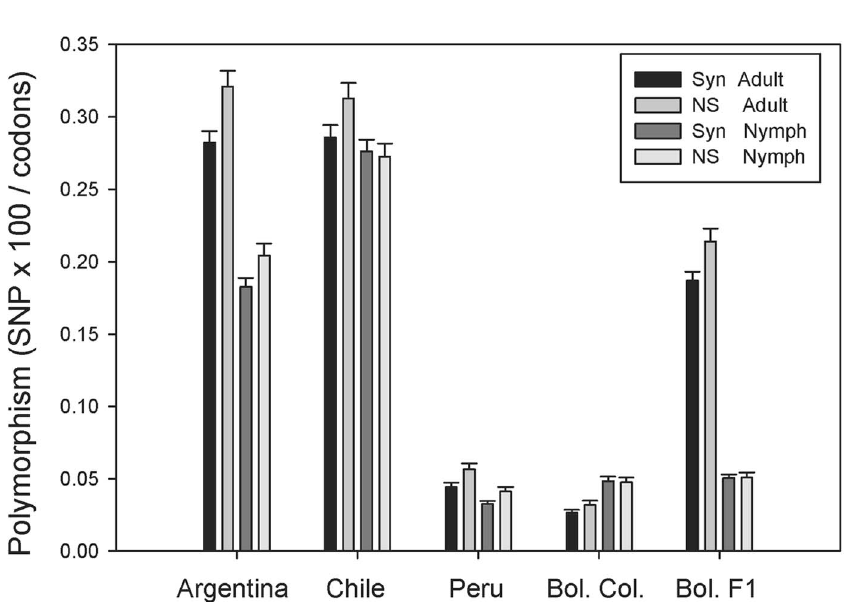
Figure 2. Polymorphism values derived from adult and nymphal coding sequences from different colonies. For each colony (Argentina, Chile, Peru, Bolivian colony and Bolivian F1) synonymous and non-synonymous single nucleotide polymorphisms were determined as indicated in the methods section. The bars represent the average and SE of 5,391 polymorphic CDS. doi:10.1371/journal.pntd.0003372.g002 PLOS Neglected Tropical Diseases |